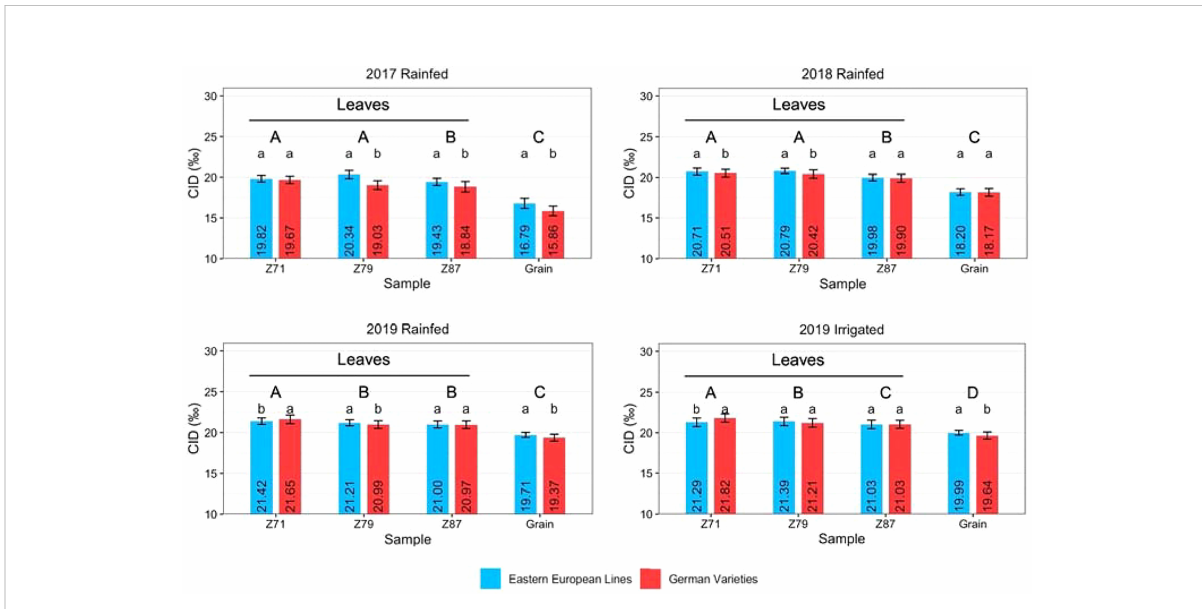
FIGURE 5 Carbon isotope discrimination (CID) of wheat leaves at Z71, Z79, and Z87 and grains of Eastern European lines and German varieties under rainfed conditions in 2017, 2018, and 2019 and under irrigated conditions in 2019. The vertical bars indicate the standard deviation of the mean. Capital letters indicate signi fi cant differences between the years, small letters indicate signi fi cant differences between origins within one year.